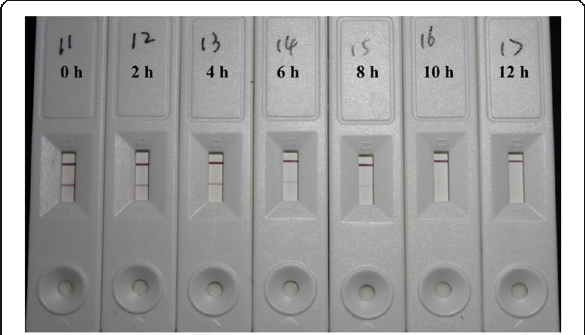
Table 1 The lethal toxicity of BoNT/A and B calculated by Reed –